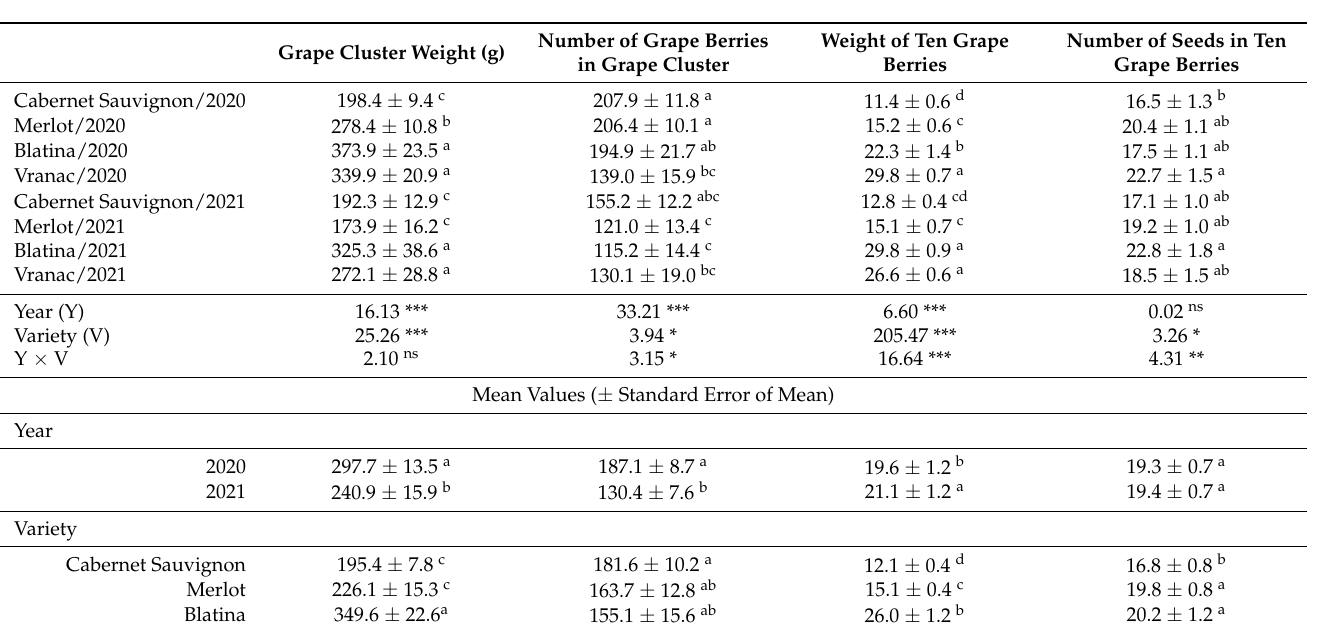
Table 3. Grape cluster characteristics of analyzed varieties during the research period at the Trebinje